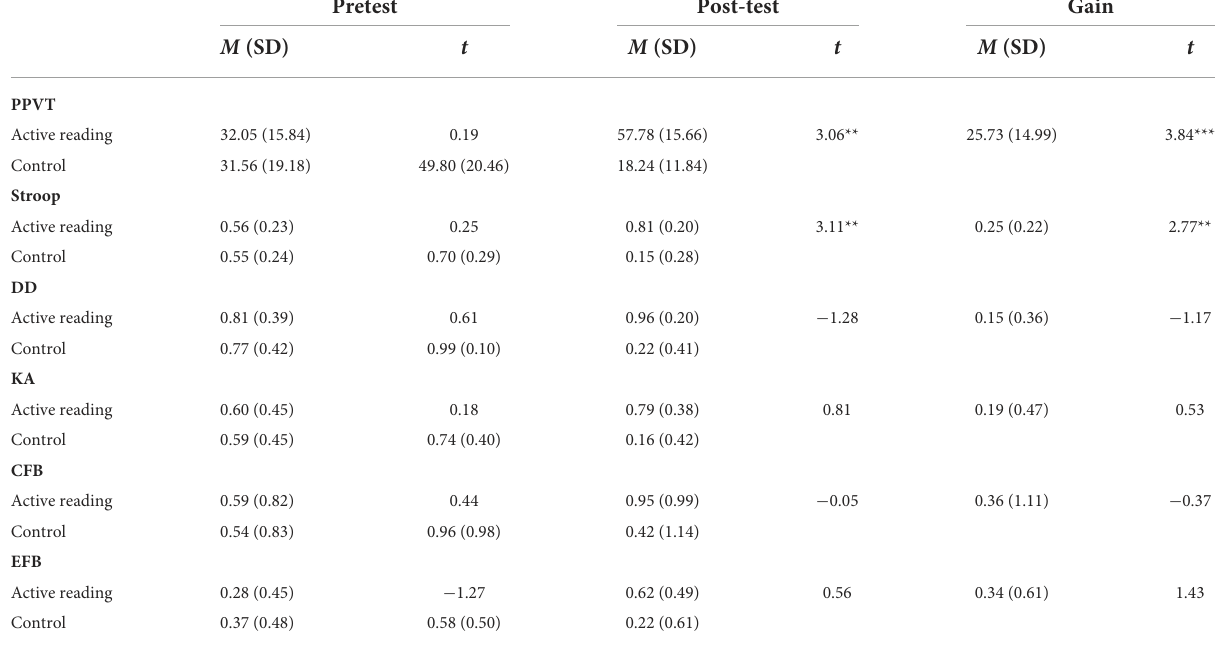
TABLE 1 Session performance for control and active reading control group.